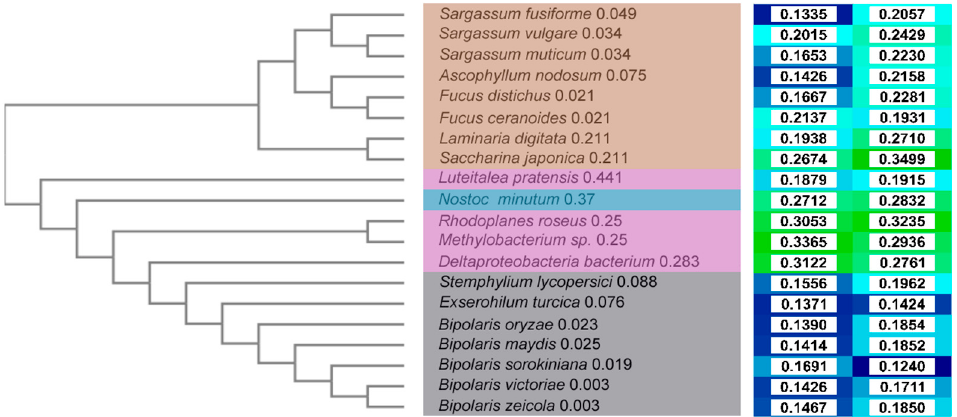
Figure 2. Comparison of sequences and model quality of haloperoxidases . Cladogram of the selected haloperoxidases ( left ). The sequences are color-coded according to the taxonomy ( center ): algae in brown, bacteria in magenta, cyanobacteria in cyan, and fungi in grey. The tree is calculated based on the distances generated from the pairwise scores (numbers in the middle column). The quality of the structural models is expressed by TopScore ( second right column ) and TopScoreSingle values ( right column ) [23] , where lower values and blue color indicate better quality.